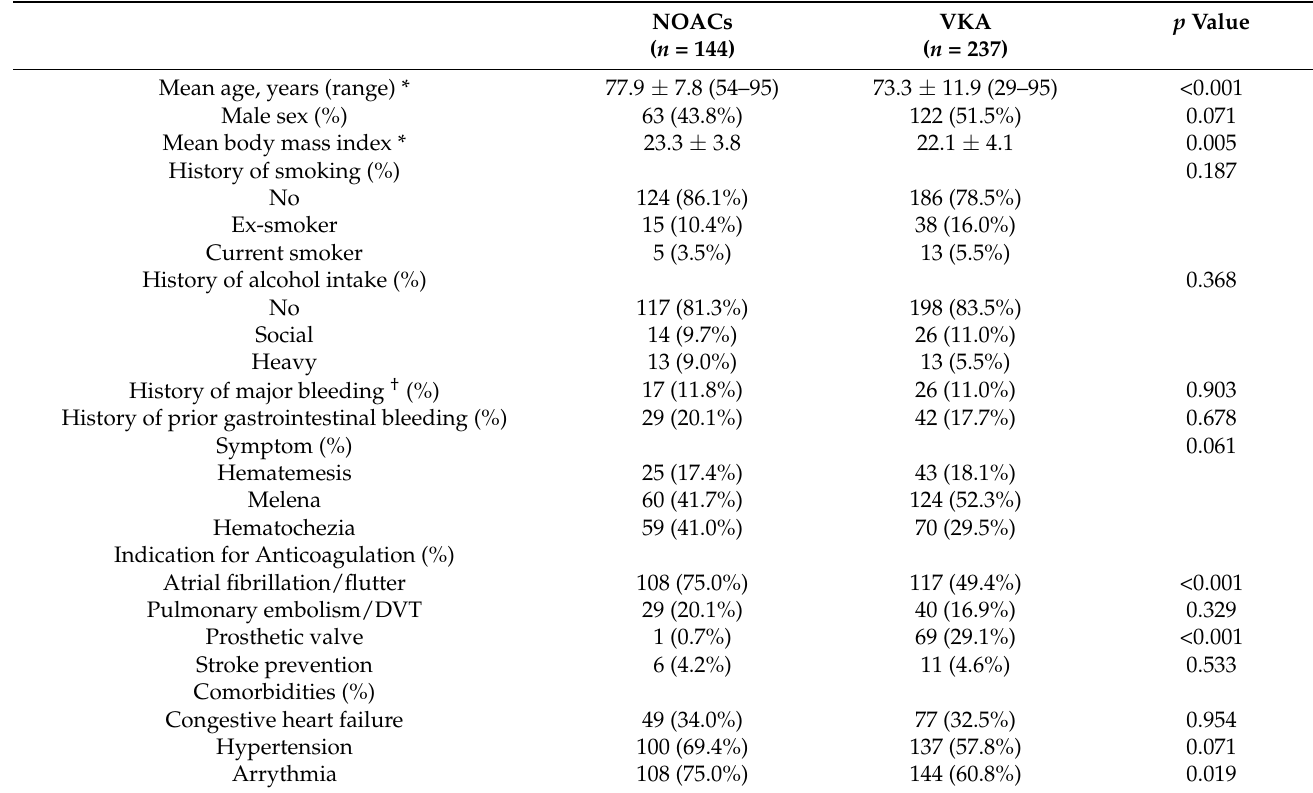
Table 1. Baseline characteristics of the patients prescribed with NOACs or VKA who experienced GI bleeding. NOACs